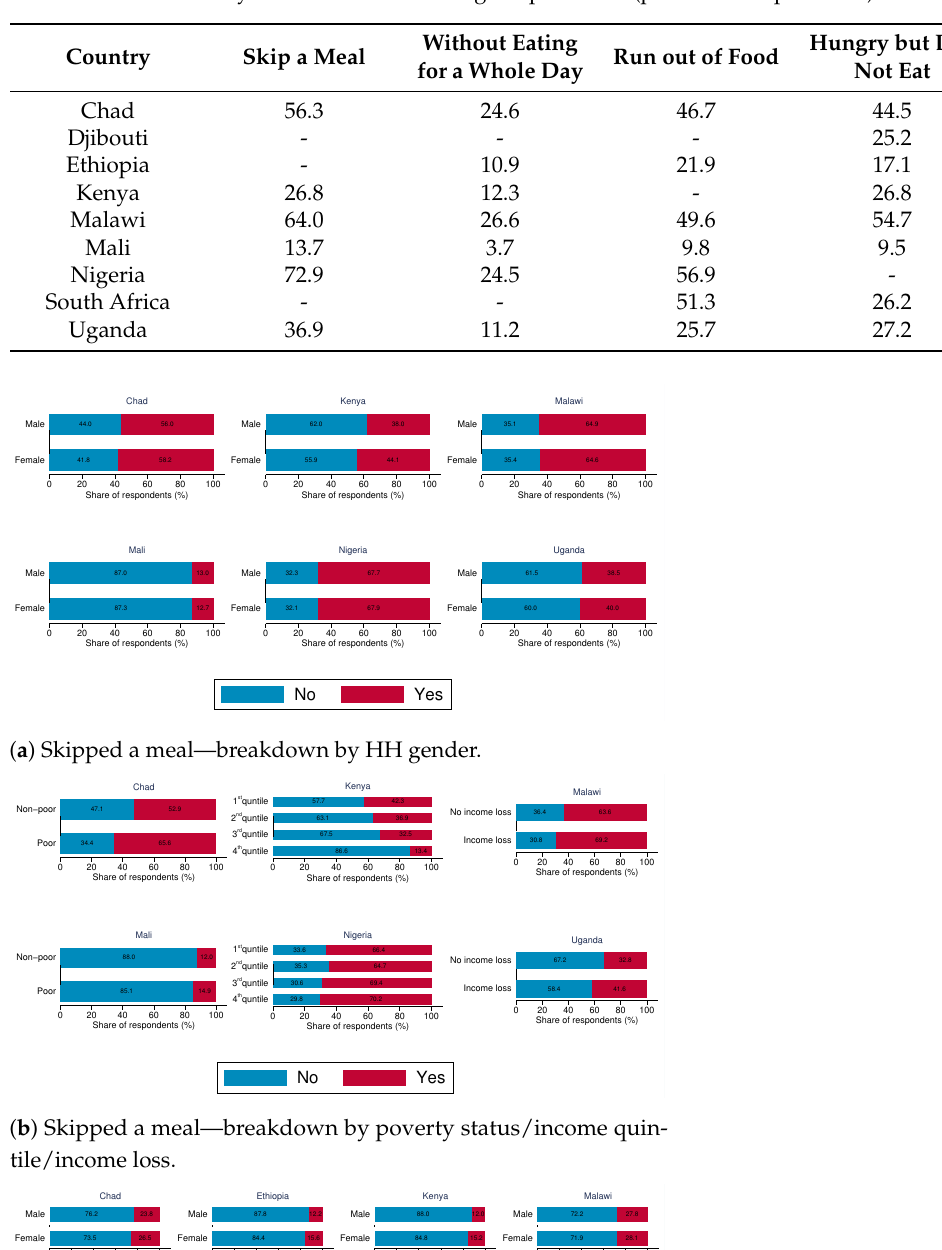
Table 1. Food insecurity across countries during the pandemic (percent of respondents).